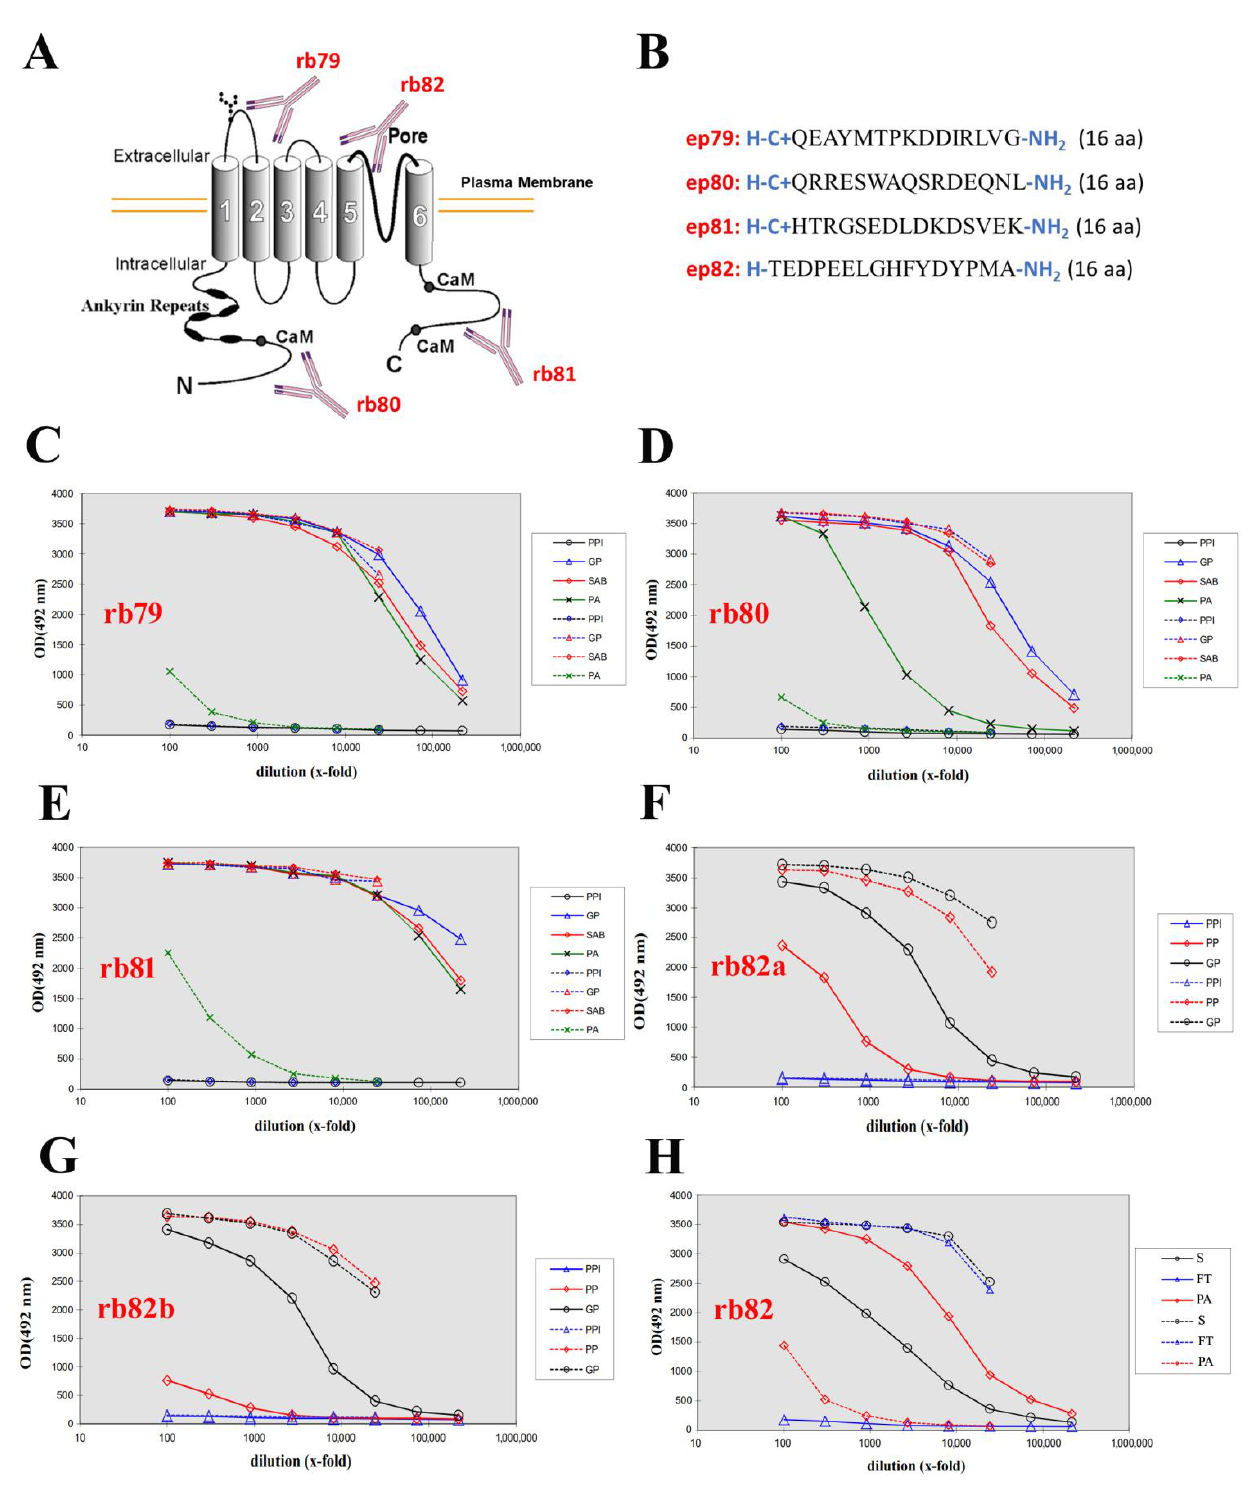
Figure 1. Design and immunoblotting of different rabbit polyclonal anti-TRPV6 channel antibodies. ( A ), The general scheme of the channel and the relative position of the epitopes for the four antibodies, 79 – 82 (base image of the channel from http://atlasgeneticsoncology.org/, accessed on the 1 May 2009). ( B ), the corresponding epitopes used to generate anti-TRPV6 antibodies, and C — cysteine used to couple with the KLH protein. ( C – H ), ELISA analysis using immobilized peptides. PPI — pre-immune serum, GP — large bleed, SAB — final bleed, PA — purified antibodies, PP — small bleed, S — serum, FT — flow through. Straight line — peptide; discontinuous line — carrier. ( C ), the ELISA analysis of the rb79 antibody. ( D ), the ELISA analysis of the rb80 antibody. ( E ), the